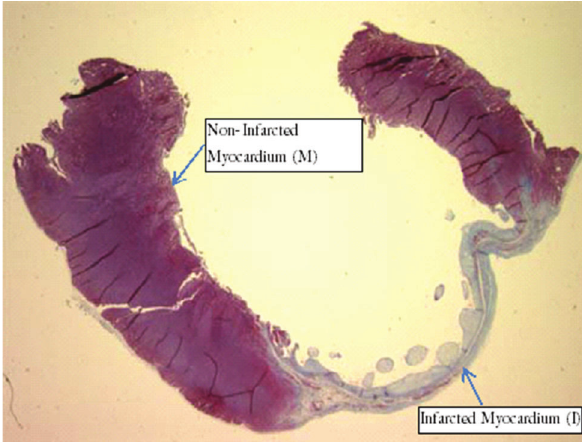
Figure 1 - Myocardium (M) and Infarction (I) from animal of sedentary group. Magnification,